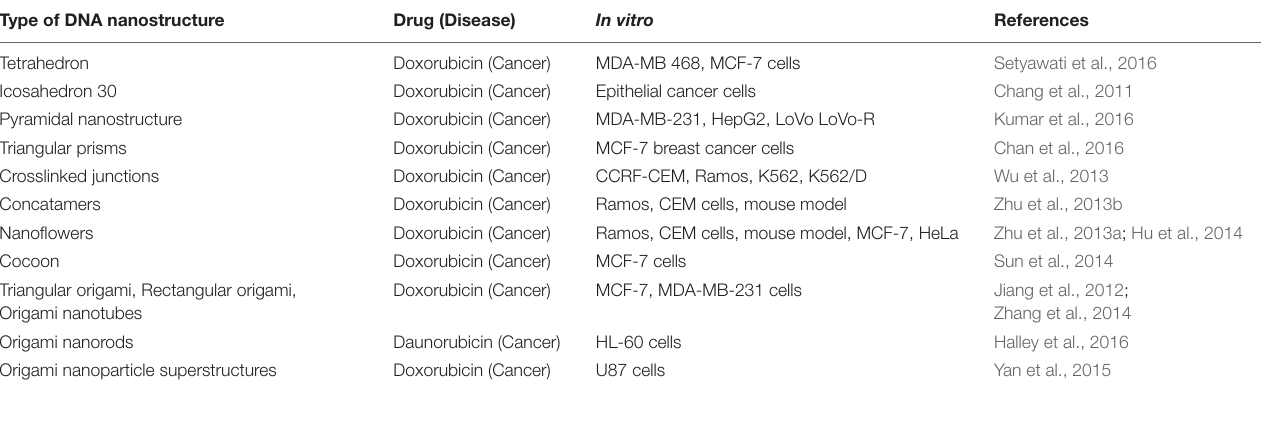
TABLE 4 | Self-assembled DNA nanostructures as drug delivery